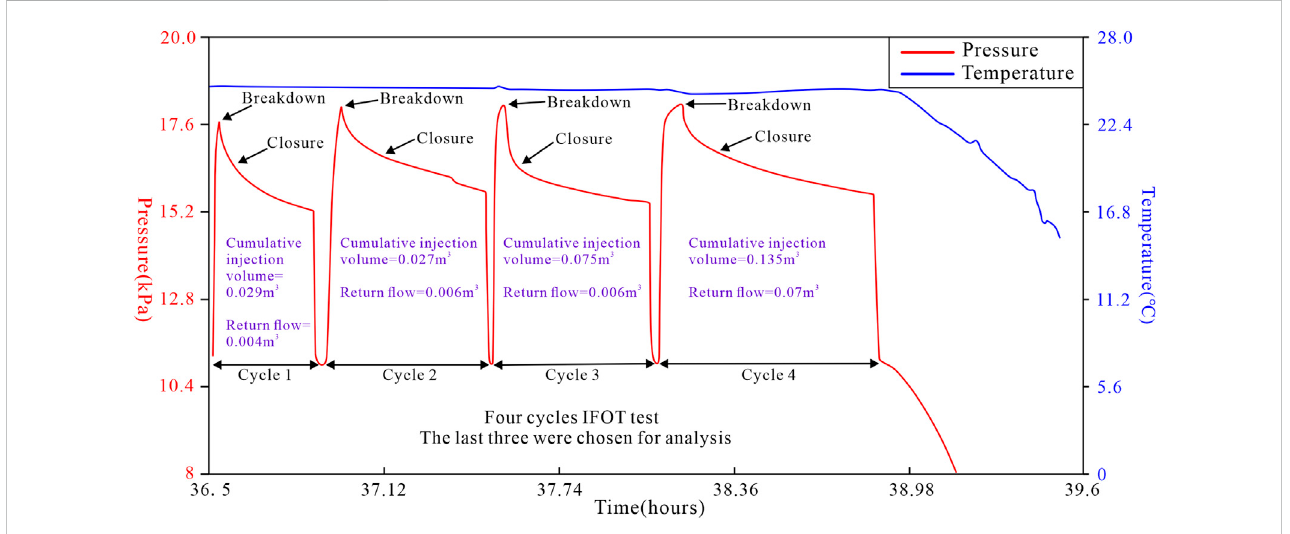
Measured pressure/temperature-time curve of in situ stress of a coal seam in